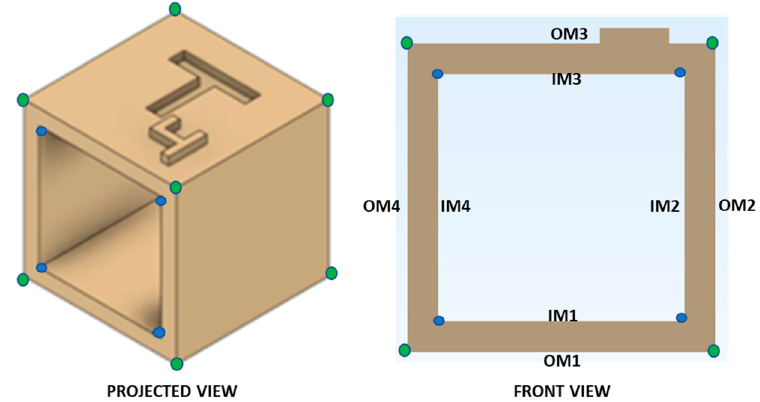
Figure 1. Projected and front view of a simplified experimental indication-specific test body design displaying the landmark points: blue points represent the landmark points for inner measurement (IM = 16 mm), while green points represent the landmark points for outer measurement (OM = 20 mm).